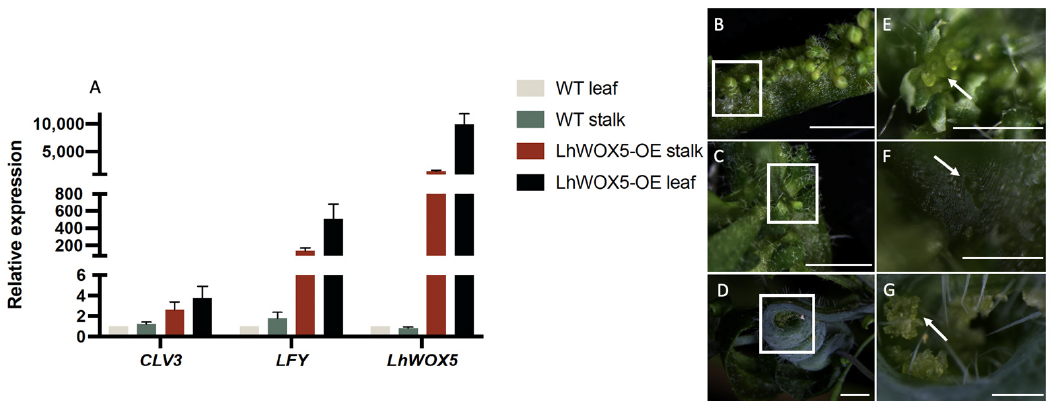
Figure 4. Relative expression of shoot meristem identity genes in Arabidopsis (T2 generation) ( A ). ( B ) Shows rosette leaves with ectopic flower buds and leaves. ( C ) Shows the same tissue as ( B ), focusing on the presence of organ primordia on rosette leaves. ( D ) Curly stalk with undetermined hyperplasia. ( E – G ) Show enlarged images of square in ( B – D ). White arrow indicates opened-flower ( E ), organ primordia ( F ), and undetermined hyperplasia ( G ), respectively. Scale bars: ( B – D ), 0.2 um; ( E – G ), 0.05 um.